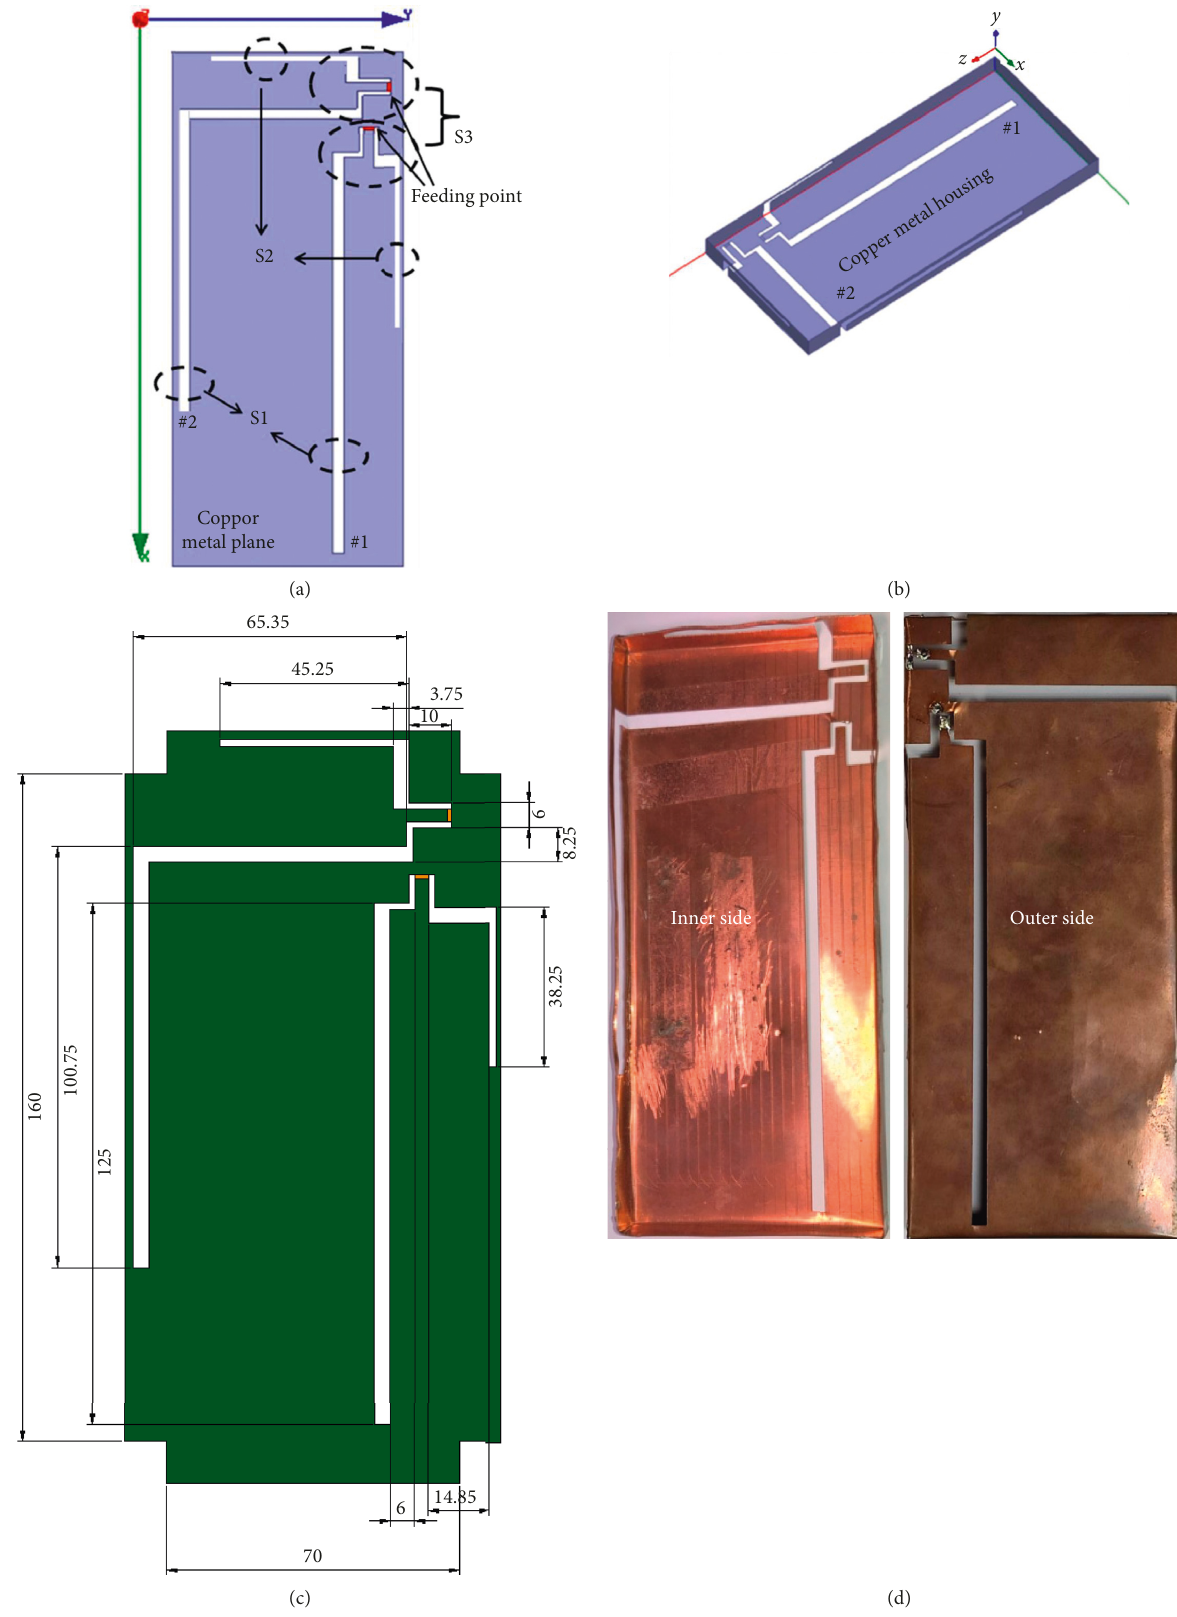
Figure 1: (a). Geometry of the proposed antenna for 2 × 2 MIMO 4G LTE full-band operation. (b). The proposed antenna chiseled in the metal-housing mobile handset (three-dimensional structure). (c). Planar dimensions of the proposed antenna (unit: mm). (d). Implemented prototype of the proposed